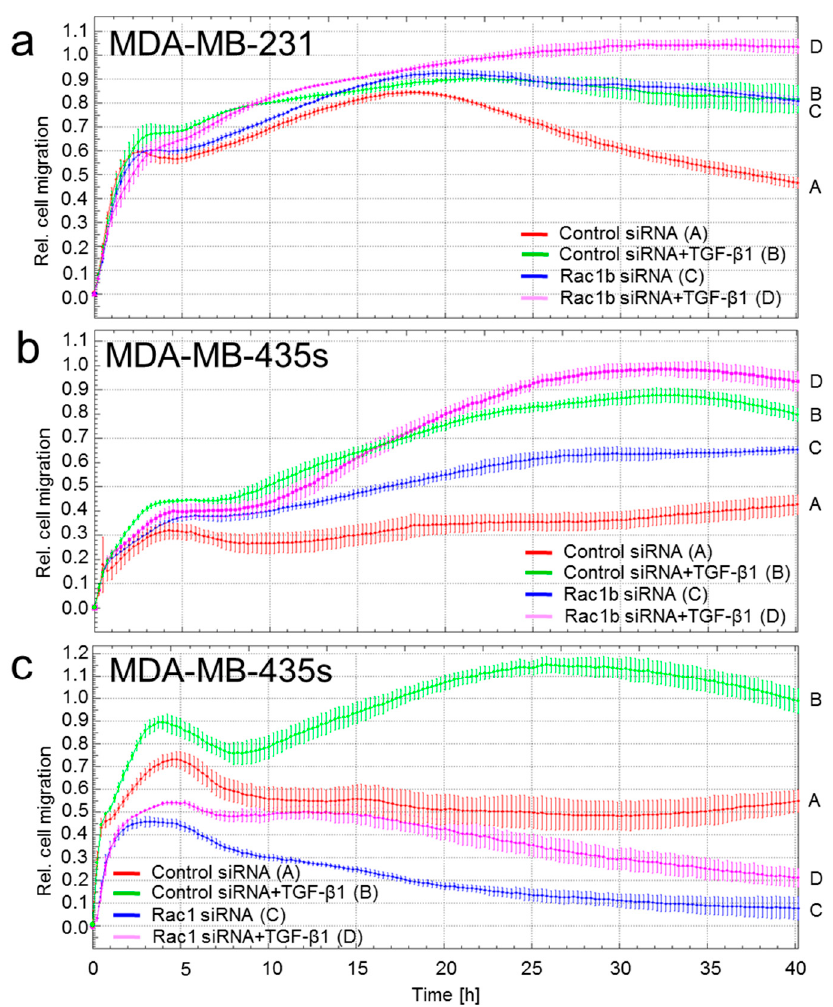
Figure 1. Effect of Rac1b or Rac1 + Rac1b depletion on TGF- β 1-mediated cell migration in MDA-MB-231 and MDA-MB-435s cells. ( a ) MDA-MB-231 cells were transiently transfected twice at two consecutive days with 50 nM of either control siRNA or Rac1b siRNA. Forty-eight hour later, cells were subjected to chemokinesis assay in the presence or absence of recombinant human (rh) TGF- β 1 (5 ng/mL). Differences are significant between control siRNA (red curve, tracing A) and Rac1b siRNA (blue curve, tracing C) and between control siRNA + TGF- β 1 (green curve, tracing B) and Rac1b siRNA + TGF- β 1 (magenta curve, tracing D) at 24:00 and all later time points; ( b ) as in (A) except that MDA-MB-435s cells were used. Differences are significant between control siRNA (red curve, tracing A) and Rac1b siRNA (blue curve, tracing C) at 15:00 and all later time points; ( c ) as in (A) except that the Rac1b siRNA was replaced by an siRNA that recognizes both Rac1 and Rac1b. Differences are significant between control siRNA (red curve, tracing A) and Rac1 siRNA (blue curve, tracing C) and between control siRNA + TGF- β 1 (green curve, tracing B) and Rac1 siRNA + TGF- β 1 (magenta curve, tracing D) at the 5:00 and all later time points. In each panel, three experiments were performed with very similar results of which one is shown.